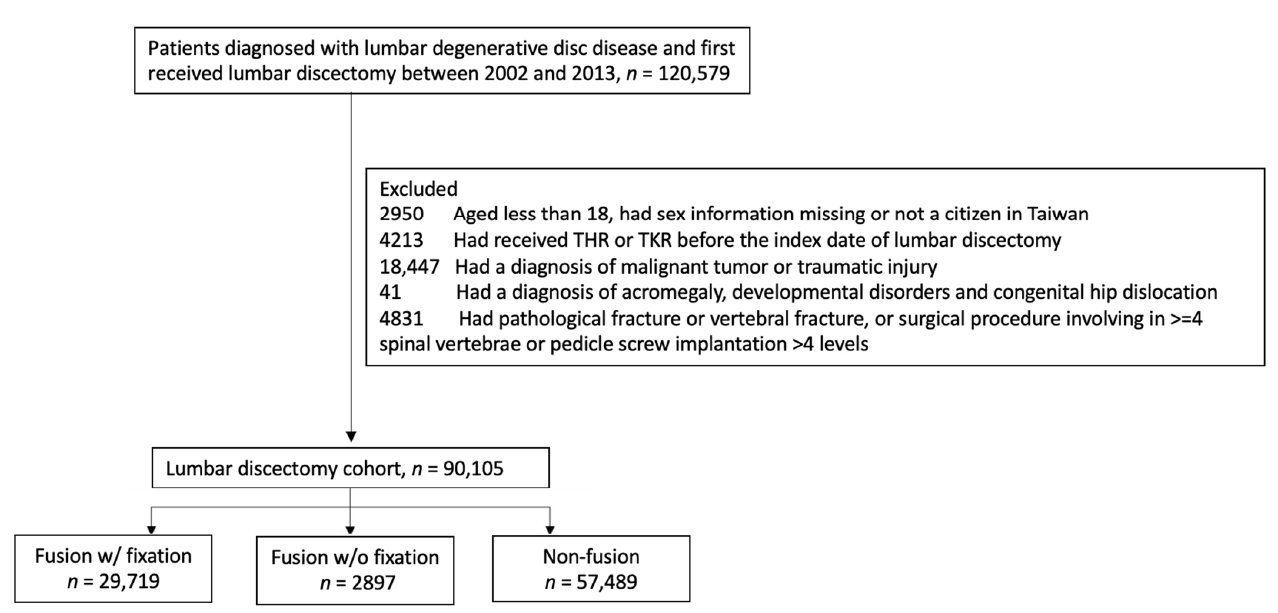
Figure 1. Patient selection process. Abbreviations: THR, total hip replacement and TKR, total knee replacement.